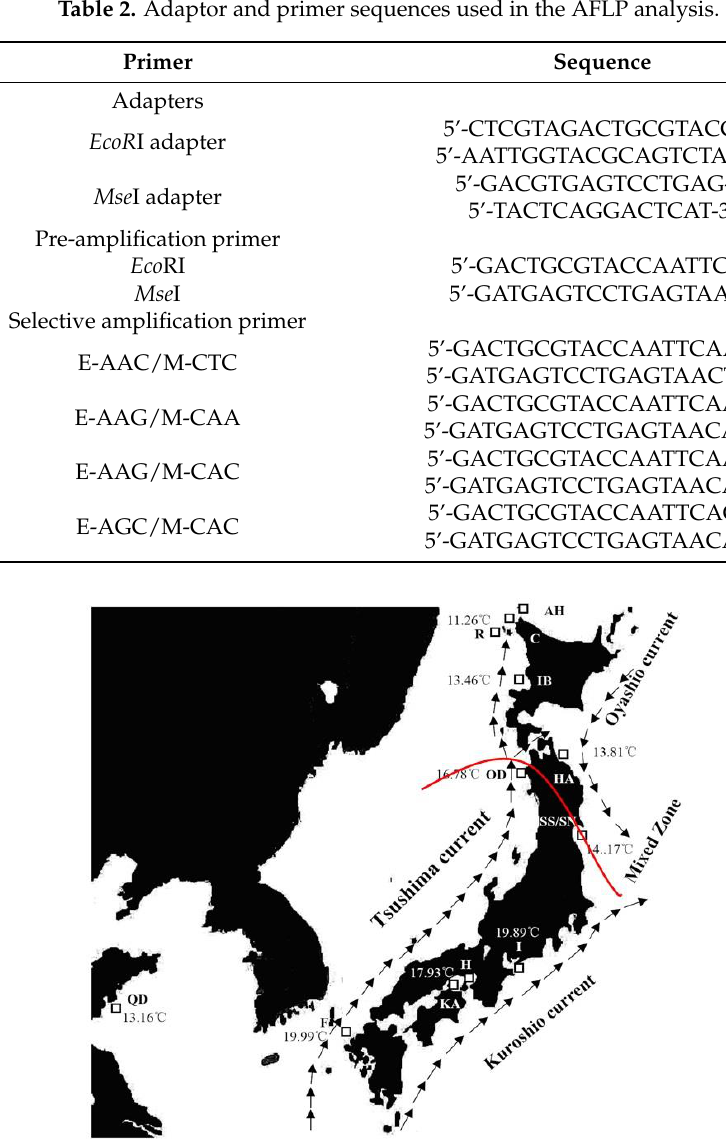
Figure 1. Map of the study area depicting sample locations, schematic map of currents, and the annual sea temperature. The samples ID in map are listed in Table 1. The predicted boundary between the northern and southern clades is represented on the map with a red line.